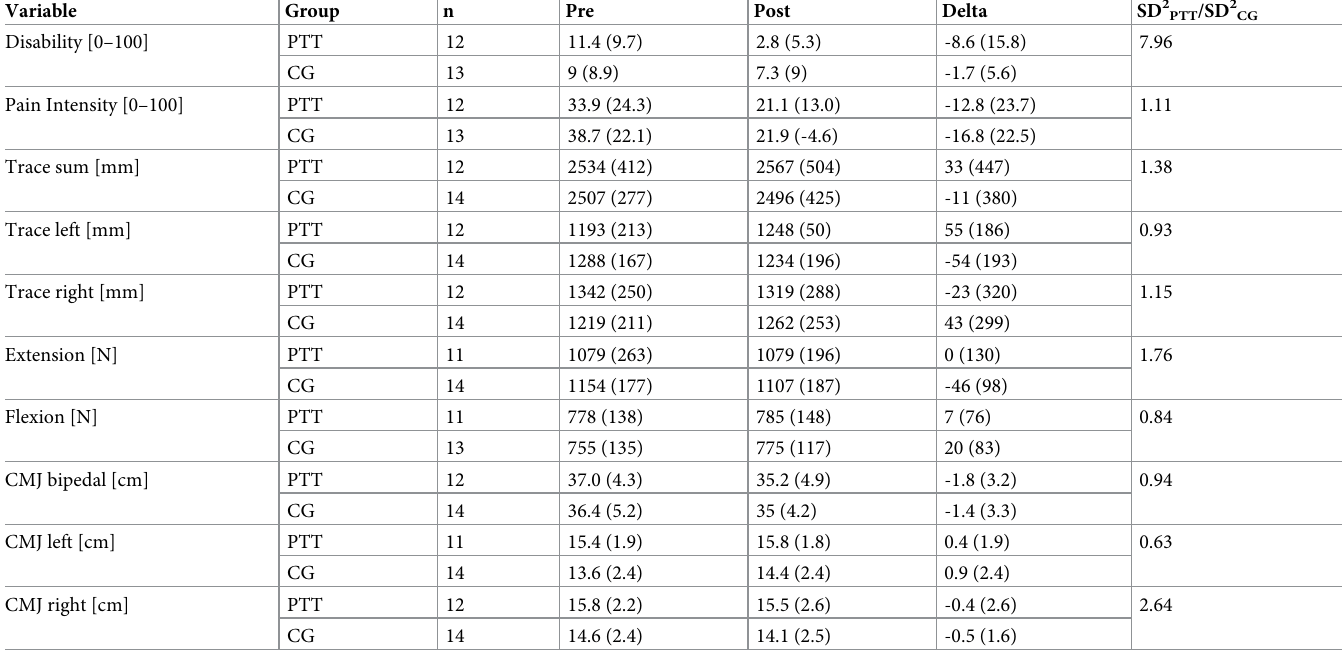
Table 2. Outcome descriptive